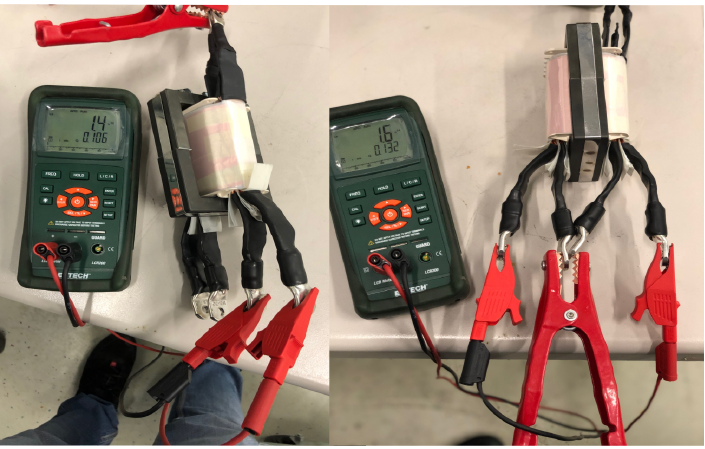
Figure 15. Developed 2.0 kW HF transformer with secondary and tertiary windings and the mea- surement of leakage inductance.